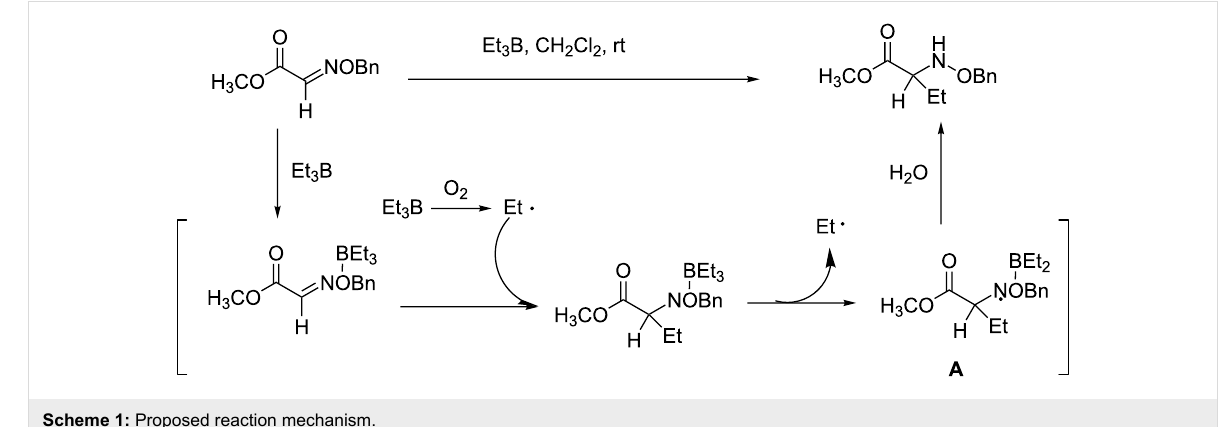
Scheme 1: Proposed reaction mechanism.